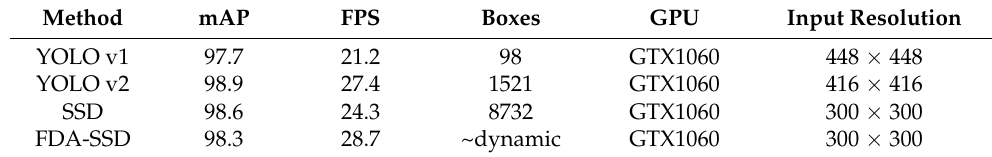
Table 1. Performance comparison of detection models based on neural network in experiment 1.